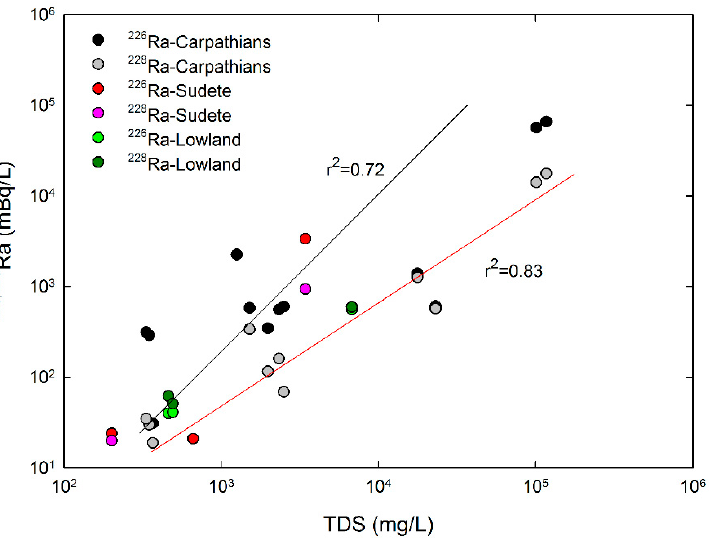
Figure 5. Relationship between the log of radium isotopes’ concentrations and mineralisation (TDS) in Polish thermal waters.